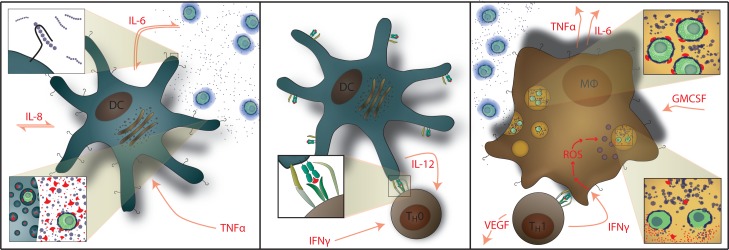
Normal Immunology of Cryptococcosis.
Left: Myeloid dendritic cells serve as APCs that recognize and phagocytose C. neoformans and generate cytokine signals of IL-1β, IL-6, and TNF-α. GXM polysaccharide capsule (i.e. CRAG) activates APCs via Toll-like receptor 4 and CD14. Center: Activated dendritic cells migrate to lymphatic tissue and present cryptococcal mannoprotein antigen to naïve T cells via MHC-II receptors. This coupled with CD28 costimulation results in Th1 differentiation. Right: Antigen-specific Th1 T cell recognition results in IFN-γ secretion causing classical activation of macrophages with up-regulation of reactive oxygen species (ROS) production; IL-6, TNF-α, IL-8 (CXCL8), CXCL10, fibroblast growth factor (FGF)-2 secretion by macrophages. T cells also secrete additional inflammatory mediators of GM-CSF and VEGF. Th2 T cell responses are not protective. Macrophages also release G-CSF which up-regulates leukotriene synthesis and anticryptococcal activity of neutrophils.